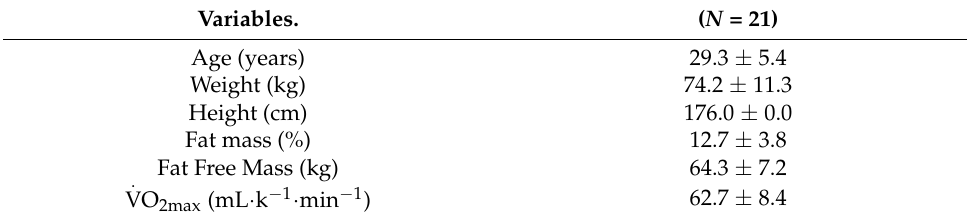
Figure 2. Flow Diagram. Table 1. General characteristics of